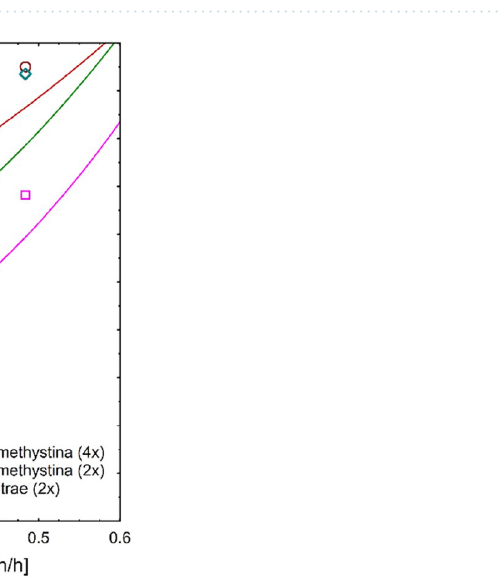
Figure 3. Correlation matrices for the obtained levels of global DNA methylation during stress and control conditions—calculated separately for each species and cytotypes: F. tatrae , F. amethystina 2 × and F. amethystina 4 ×. Blue and red fields—statistically significant negative and positive correlations respectively; white fields have statistically insignificant correlations (p < 0.05).